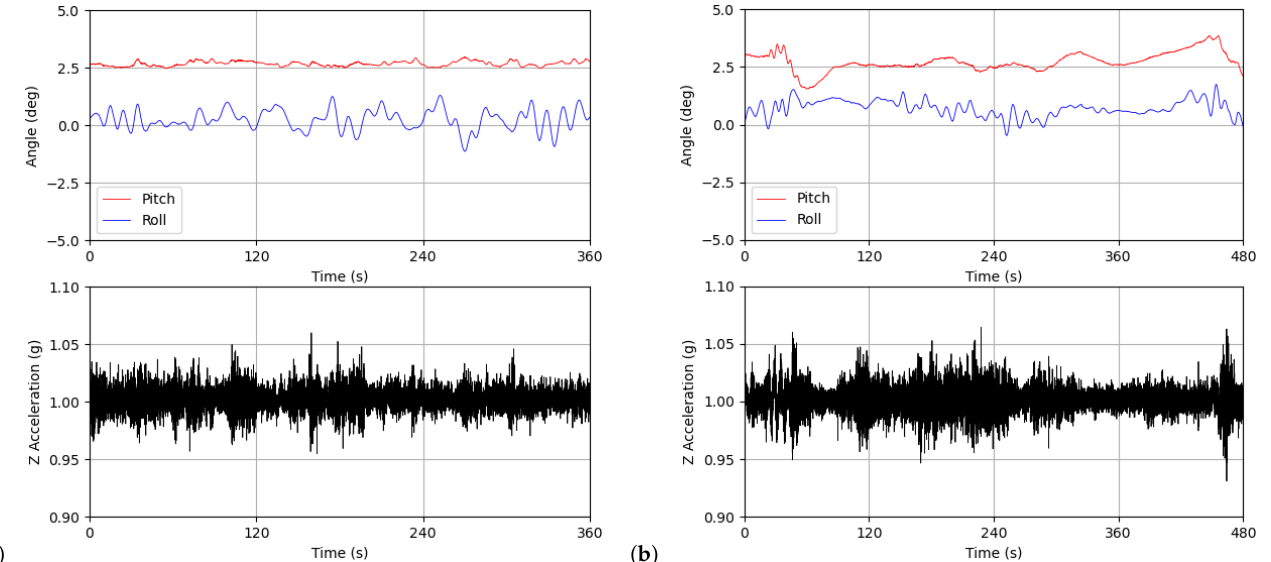
Figure 23. Pitch, roll and heave accelerations of the ship during the icebreaking operations on: Figure